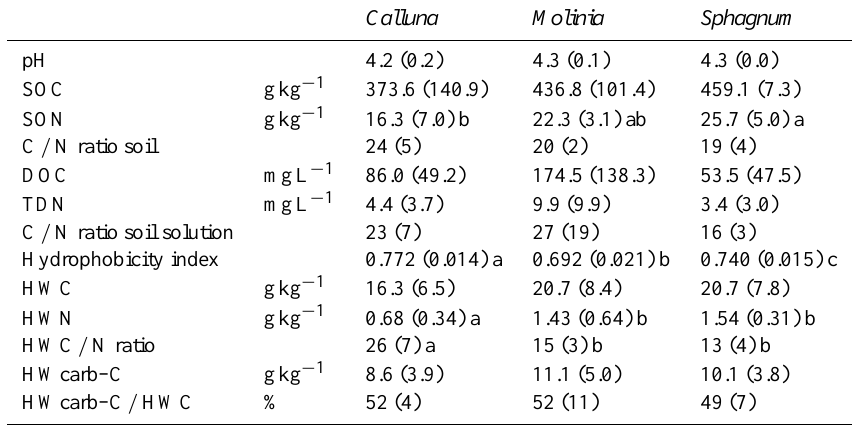
Table 2. Selected properties of the topsoil according to dominant vegetation. Values in parentheses are standard deviations of six independent replicates. Lower-case letters indicate significant differences ( p <